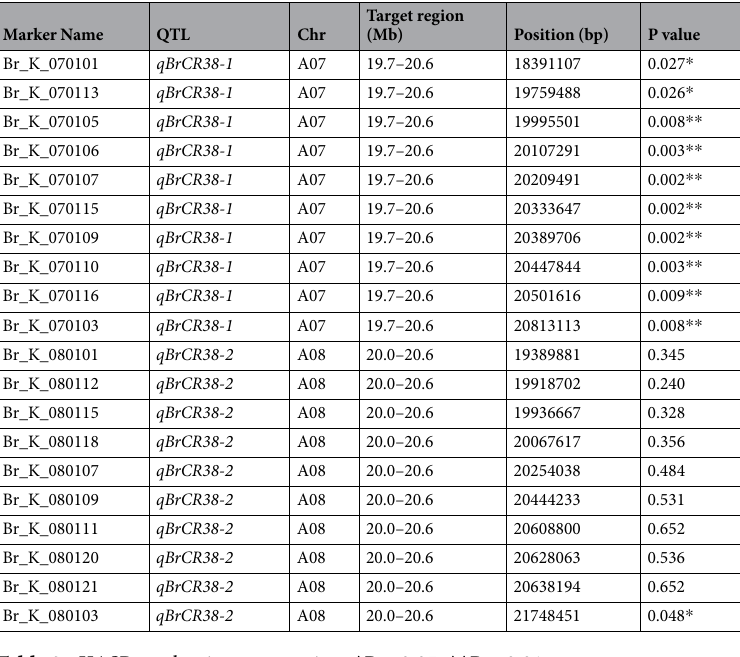
Table 3. KASP marker in target region. * P < 0.05, ** P < 0.01.